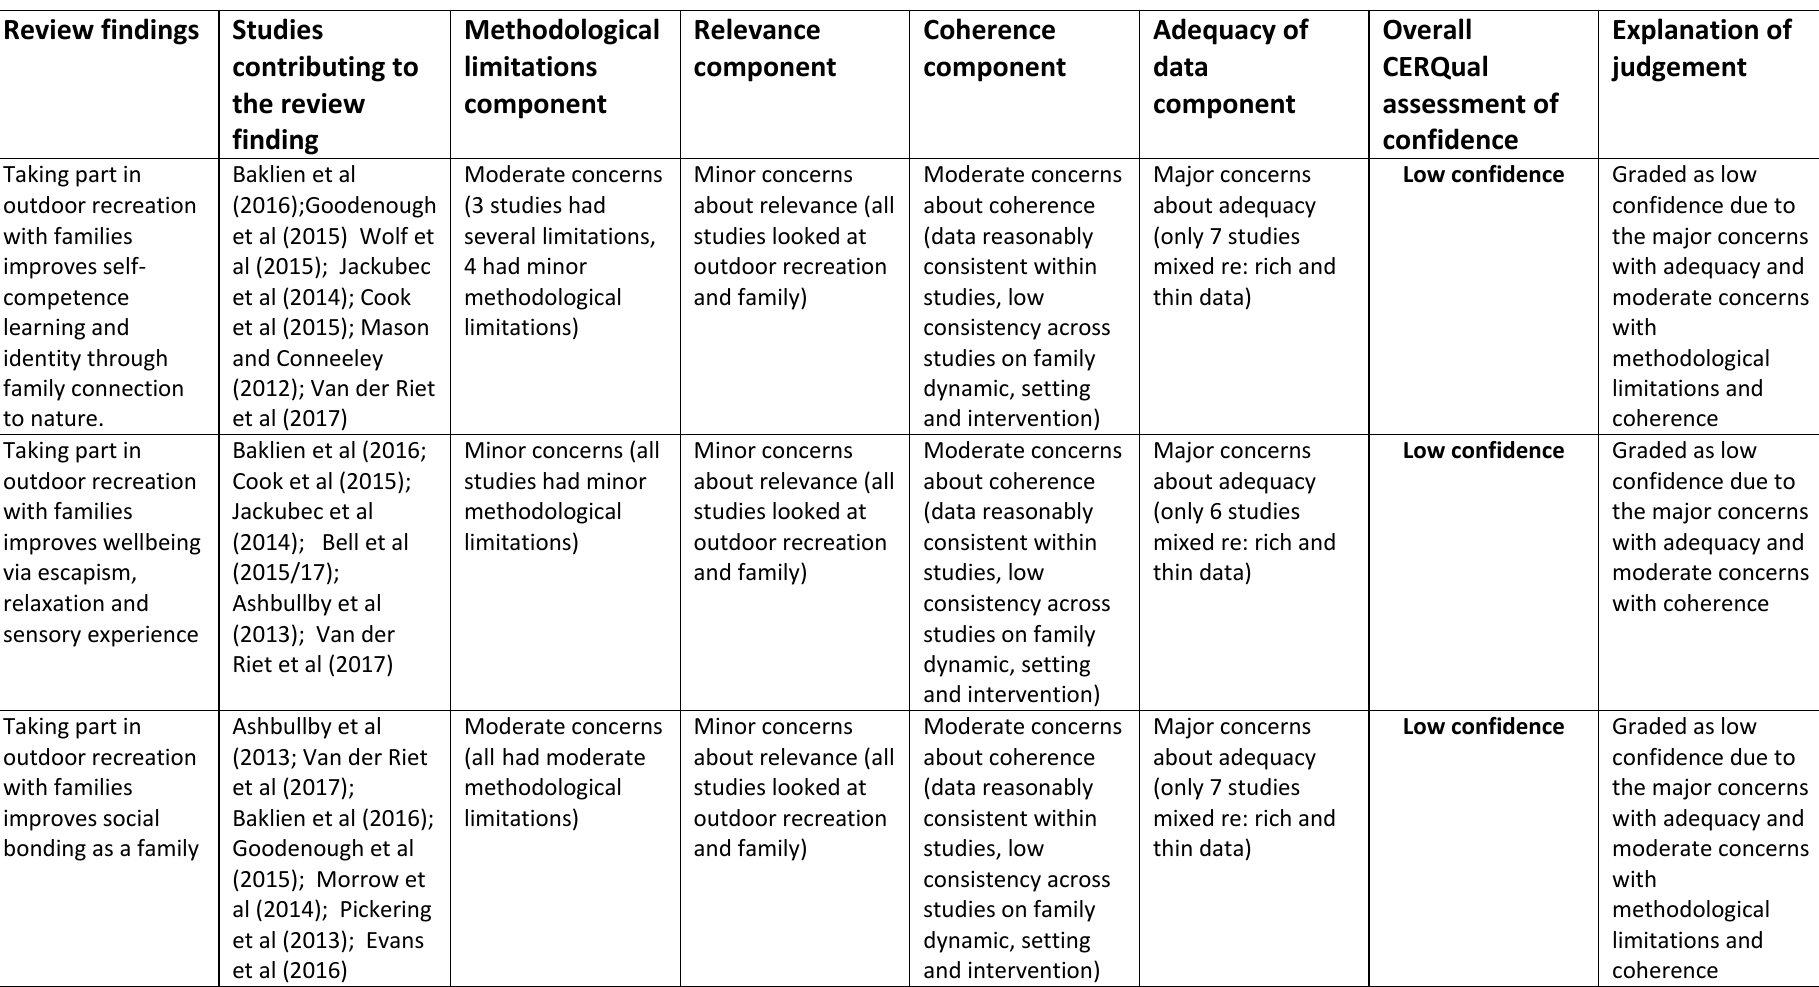
Table 6: CERqual Qualitative Evidence Profile Review